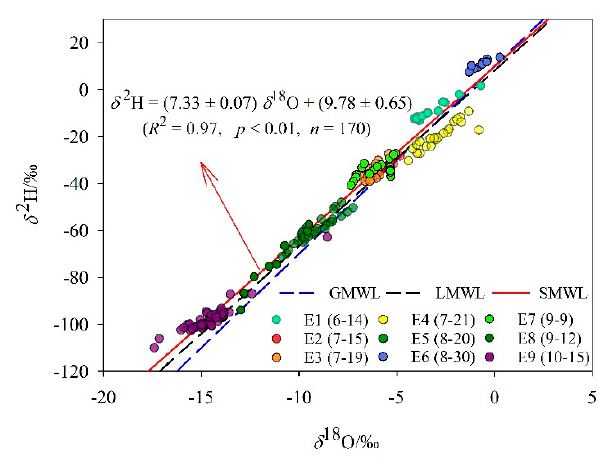
Figure 4. δ 18 O and δ 2 H relationships during the nine precipitation events from June to October 2019.